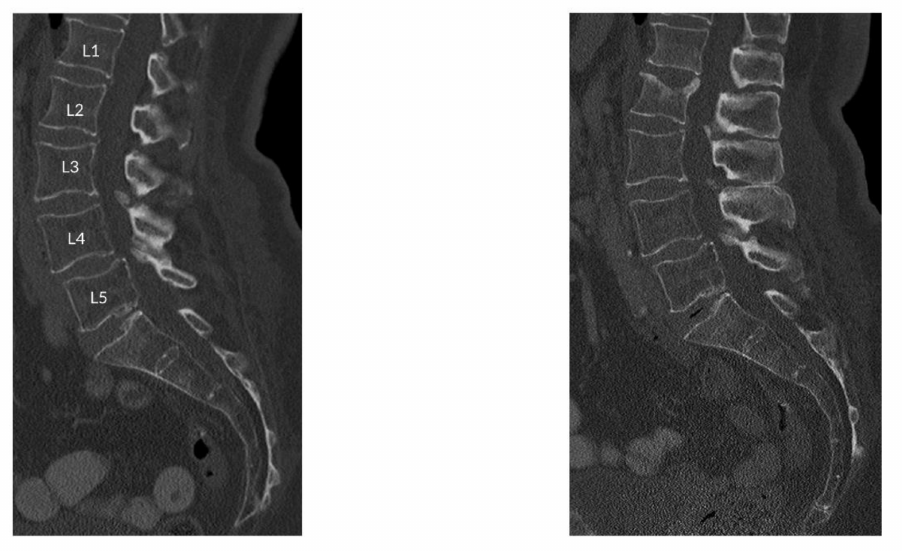
Figure 1. Sagittal reformation of a representative patient with incidental osteoporotic vertebral fracture of L2 at